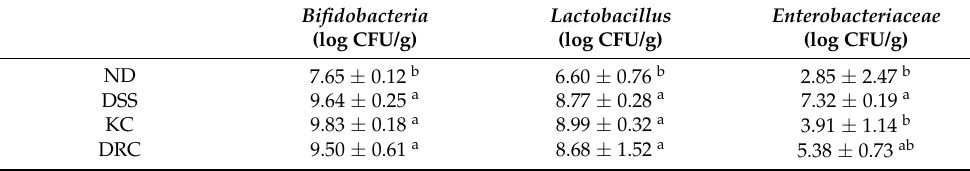
Figure 3. Effects of kimchi and Leu. mesenteroides DRC 1506 on colon length ( A , B ), colon weight/length ( C ), and histopathology ( D ). ( A ) Representative photographs of colon tissue in each group. ( B , C ) The colon length and colon weight-to-length ratio are presented as scatter plots with median, minimum and maximum values ( n = 8 mice per group). Comparisons among groups were evaluated using one-way ANOVA with Duncan’s post hoc test. Groups with different letters had a significant difference at p < 0.05. ( D ) Representative images of H&E staining of colonic sections in each group. Three histological sections were analyzed per animal, with n = 3 mice per group. Arrows represent the following histological lesions: crypt destruction (black), reduced goblet cells (blue), inflammatory cell infiltration (yellow), and colonic mucosal erosion (red). Scale bar = 100 μ m and 200 μ m. ND, normal group; DSS, DSS-treated group; KC, DSS + 1 × 10 9 CFU/day/mouse of kimchi group; DRC, DSS + 1 × 10 9 CFU/day/mouse of Leu. mesenteroides DRC 1506 isolated from kimchi. Table 1. Effect of kimchi and Leu. mesenteroides DRC 1506 on some gut microbial